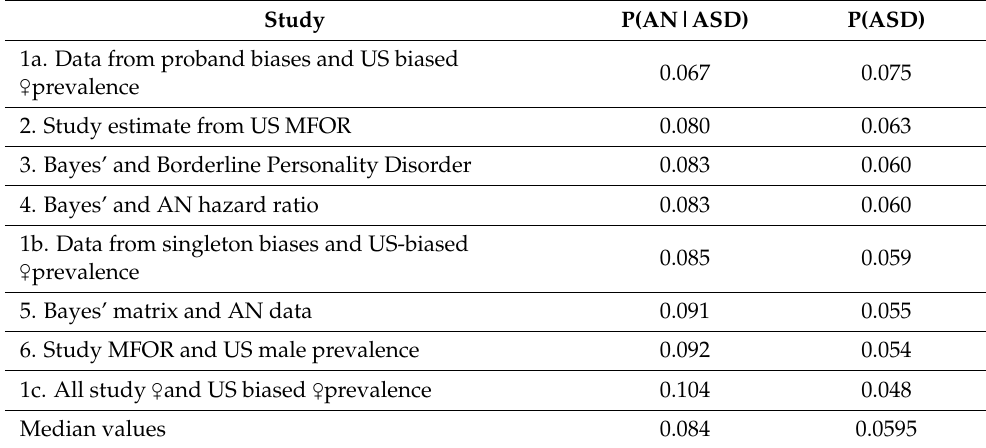
Table 4. P(AN|ASD) and P(ASD) estimates.